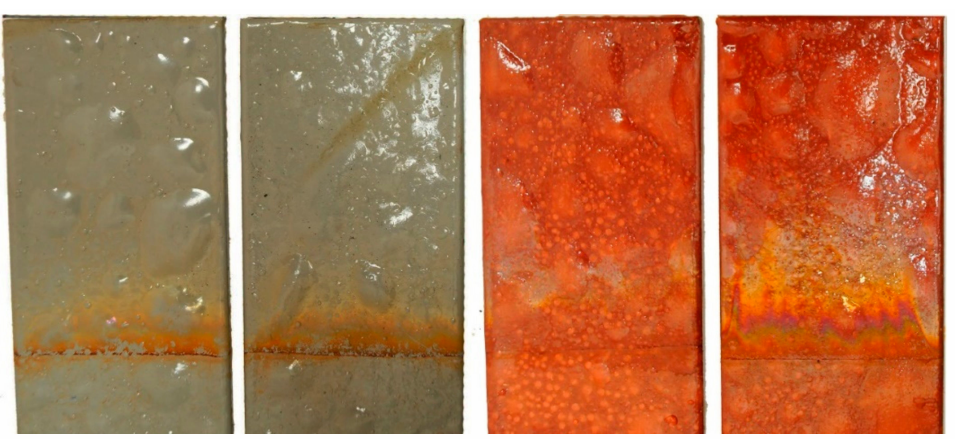
Figure 4. Samples with blisters after autoclave decompression